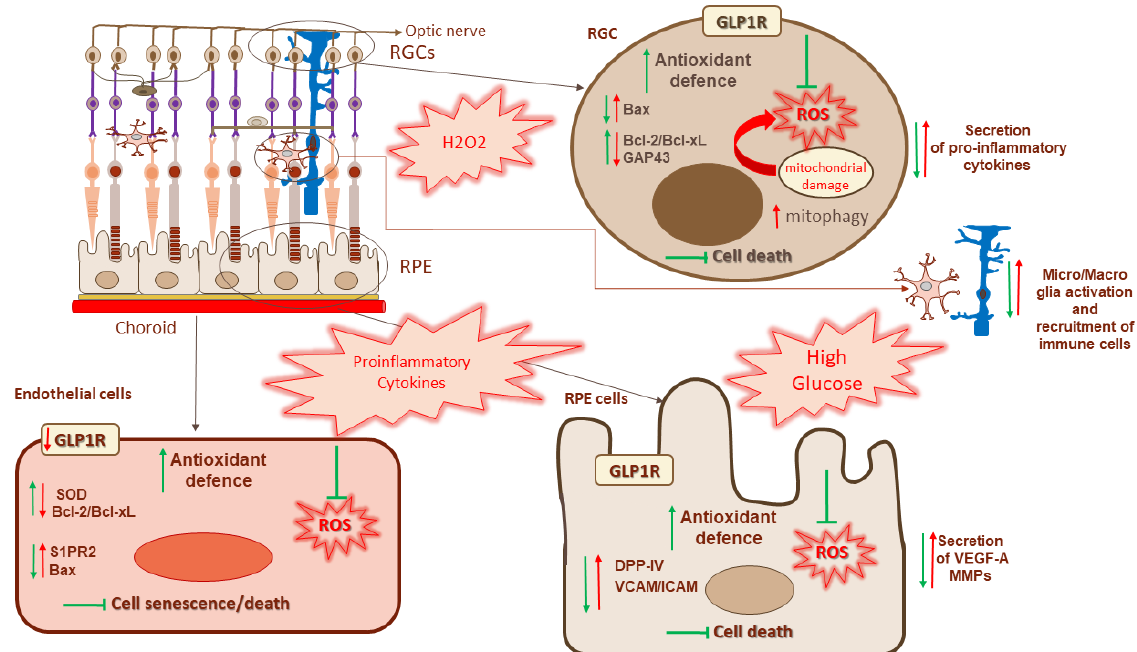
Figure 1. Schematic representation of retinal layers with highlight on retinal ganglion cells (RGCs), retinal pigment epithelium (RPE) and choroid. Overview of the main detrimental effects of proin- flammatory factors (cytokines, high glucose concentration and H 2 O 2 ) are represented in red with arrows and text in each cell type. The effects of GLP-1R activation are represented in green.